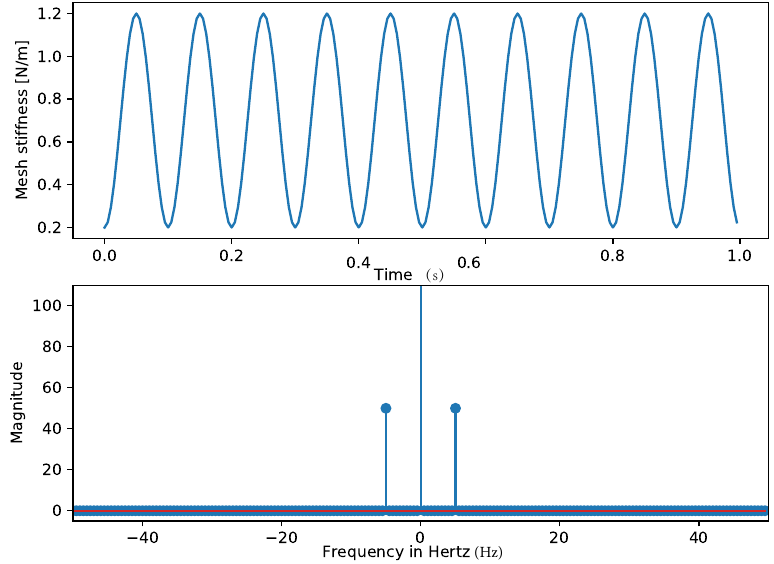
Figure 3. Time-dependent mesh stiffness with its frequency